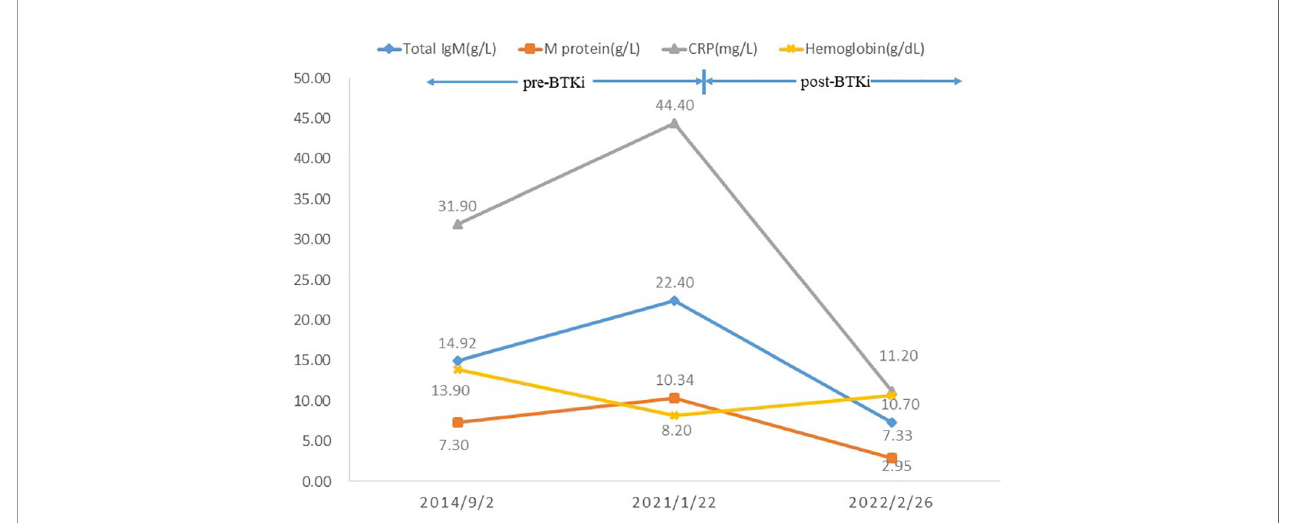
FIGURE 2 | Trends of laboratory fi ndings pre- and post-BTK inhibitor ibrutinib